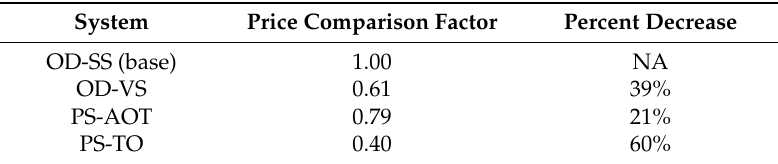
Table 13. Price Comparisons between systems with OD-SS as a